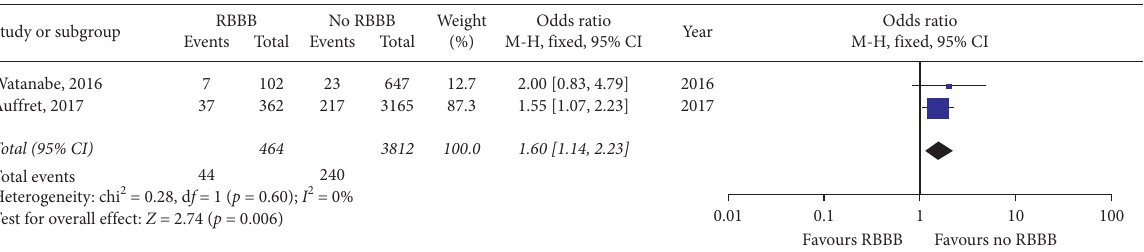
Figure 3: Forest plot of 30-day all-cause mortality rate in patients with and without preexisting RBBB after TAVR.